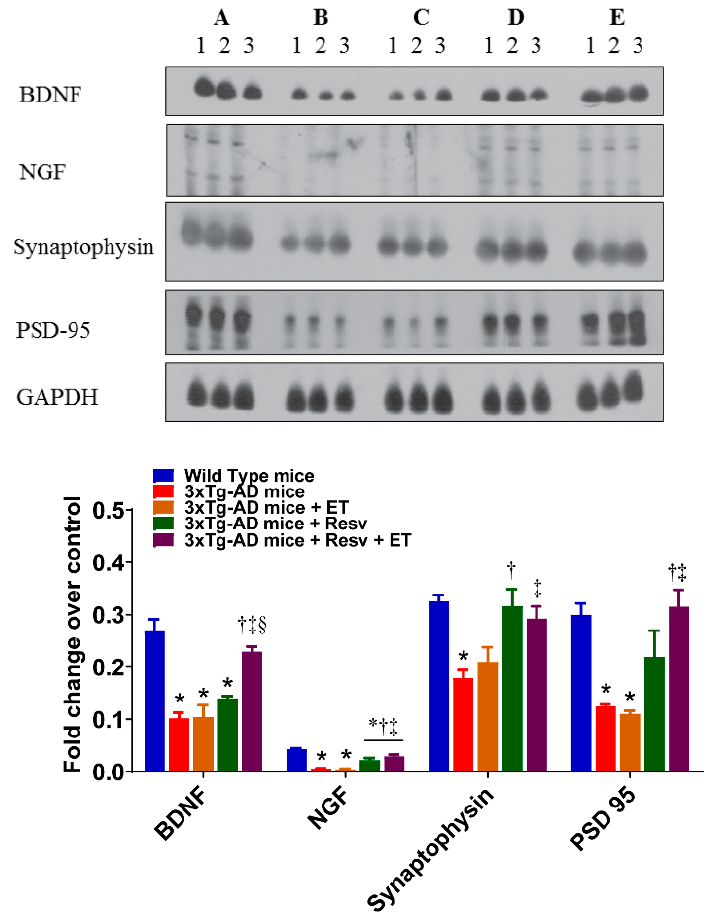
Figure 4. The effects of Resv and ET on the expression of neurotrophins and synaptic markers. Treatment with Resv or Resv with ET increased the expression of neurotrophins and synaptic markers. Representative immunoblots show significant increases in expression of the neurotrophins BDNF, NGF and synaptic markers synaptophysin and PSD-95 in 3xTg-AD mice treated with Resv or Resv with ET. Corresponding densitometry measurements: A, WT mice; B, 3xTg-AD mice; C, 3xTg-AD mice + ET; D, 3xTg-AD mice + Resv; E, 3xTg-AD mice + Resv + ET. BDNF, brain-derived neurotropic factor; NGF, nerve growth factor; PSD95, postsynaptic density 95. AD, Alzheimer’s disease; ET, exercise training; Resv, resveratrol. Data are presented as mean ± SEM for 3 mice per group. *, compared to WT mice, p < 0.05; † , compared to 3xTg-AD mice, p < 0.05; ‡ , compared to 3xTg-AD mice + ET, p < 0.05; § , compared to 3xTg-AD mice + Resv.